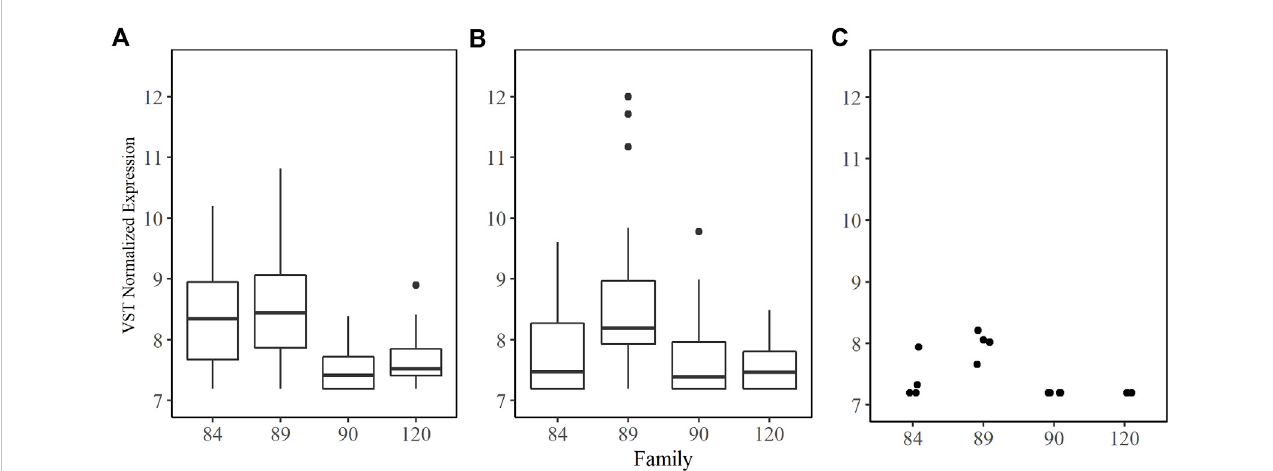
Variance stabilizing transformation normalized counts by family for (A) median expression of 11 tripartite motif-containing protein (TRIM) transcripts shared between magenta module and DESeq2 comparisons for family 84 and 89; (B) median expression of seven serine Protease Inhibitors (SPI) found in the magenta module; and (C) expression for serine protease inhibitor Cvsi-2 (XM_022434710.1) found in the magenta